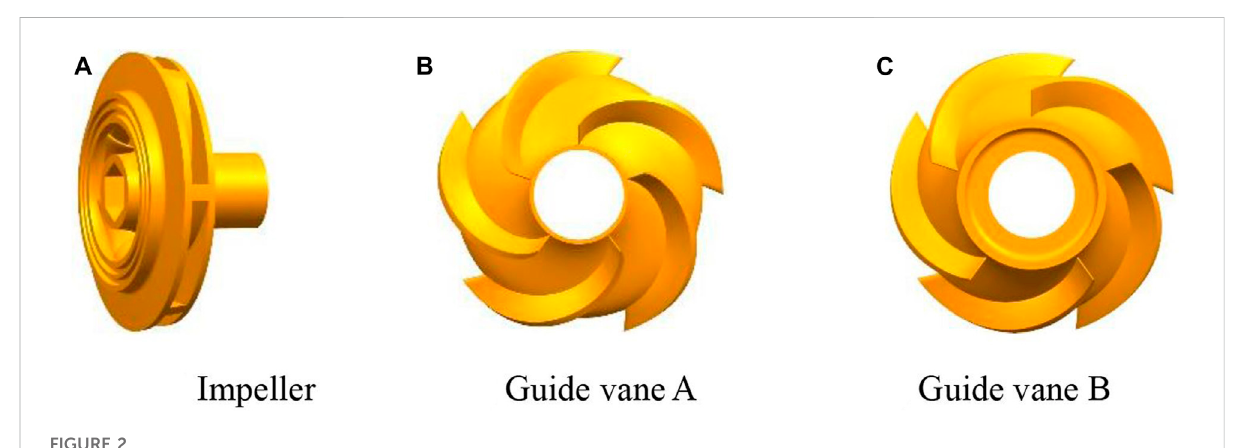
FIGURE 2 Three-dimensional models of impeller and